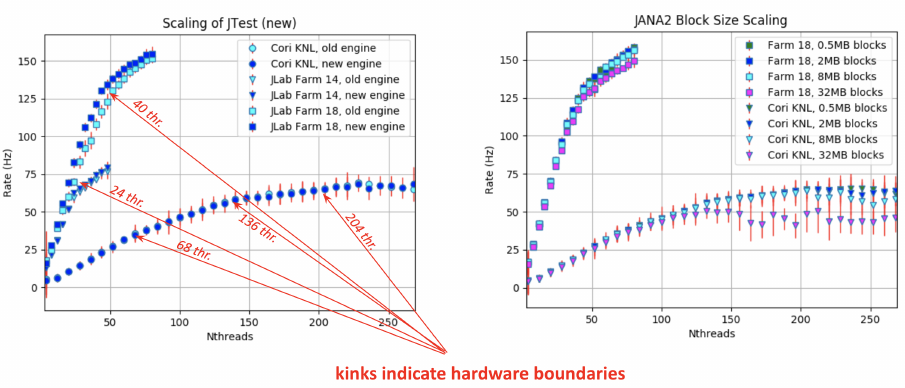
Figure 4. Plots demonstrating the scaling of JANA2 processes on multiple architectures including traditional Intel CPUs (e.g. Haswell) and KNL. The plot on the left shows event rate scaling as a function of the number of processing threads. The plot on the right shows similar scaling but for the size of the data blocks. In both cases, kinks in the distribution come at boundaries where the number of physical cores are exhausted and hyperthreading is activated. For the KNL architecture, up to 3 hyperthreads per full core are available so 4 distinct regions are